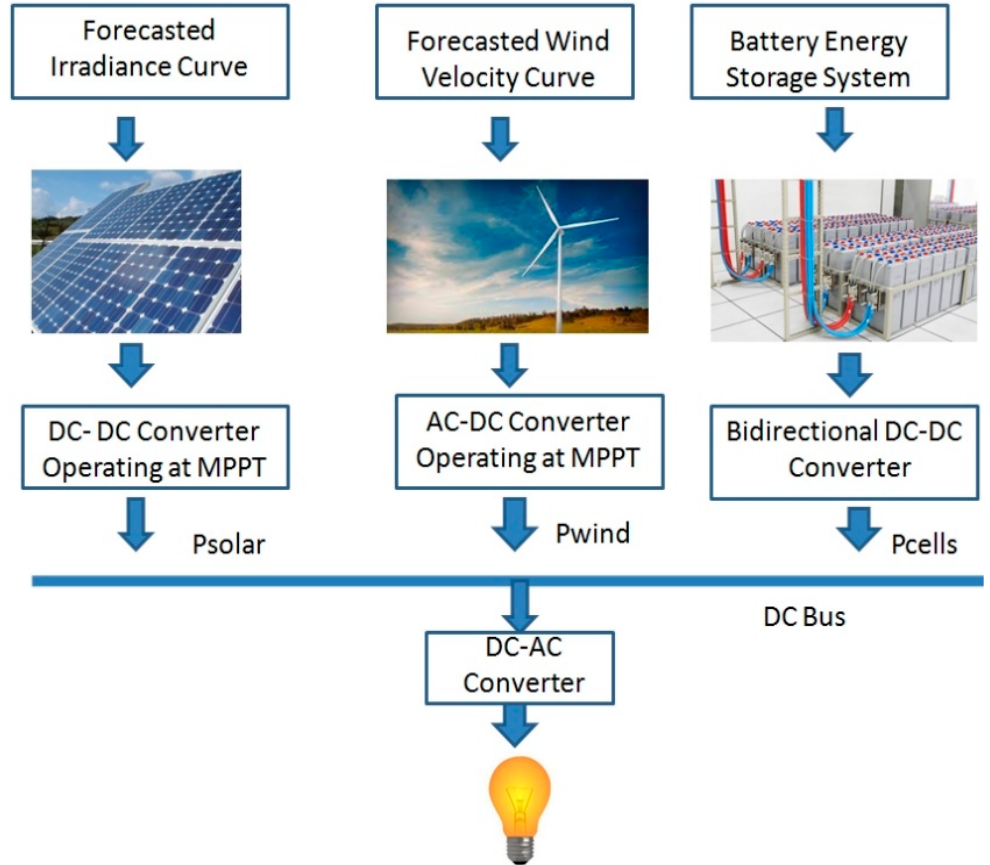
Figure 1. Proposed system architecture.